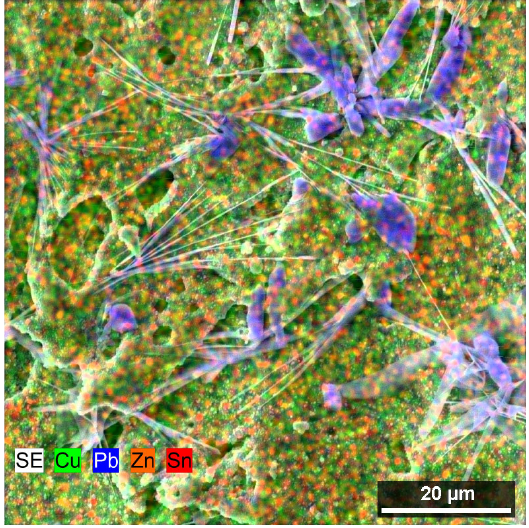
Materials 2023 , 16 , x FOR PEER REVIEW Figure 8. Distribution map of the individual elements in the area of occurrence of SEM/SE needles.